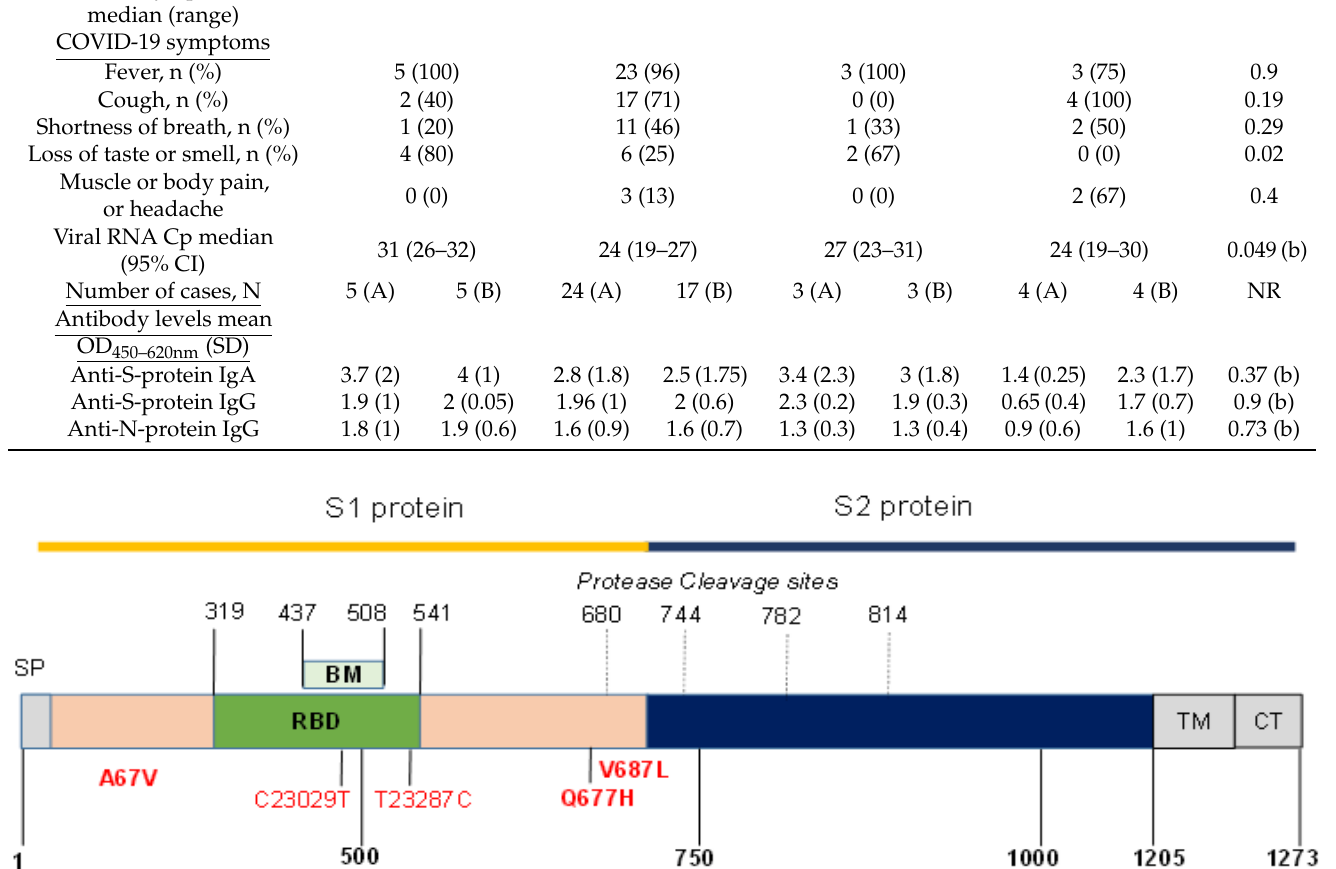
3 and group 4 show a trend for lower Cp values than that of group 1, but the number of cases is insufficient to assess if the differences in viral loads are of statistical significance. Table 1. Patient characteristics. The patient characteristics in four groups of SARS-CoV-2 variants were compared. The p -values are either the rank sum of median differences between group 1 versus group 2 in the Mann–Whitney independent test or the difference in proportions between group 1 versus group 2 in the Chi-square analysis (b). Time points (A) = day 2 or 3 and (B) = day 13 or 14 post onset of COVID-19 symptoms (POCS). NR = not relevant.